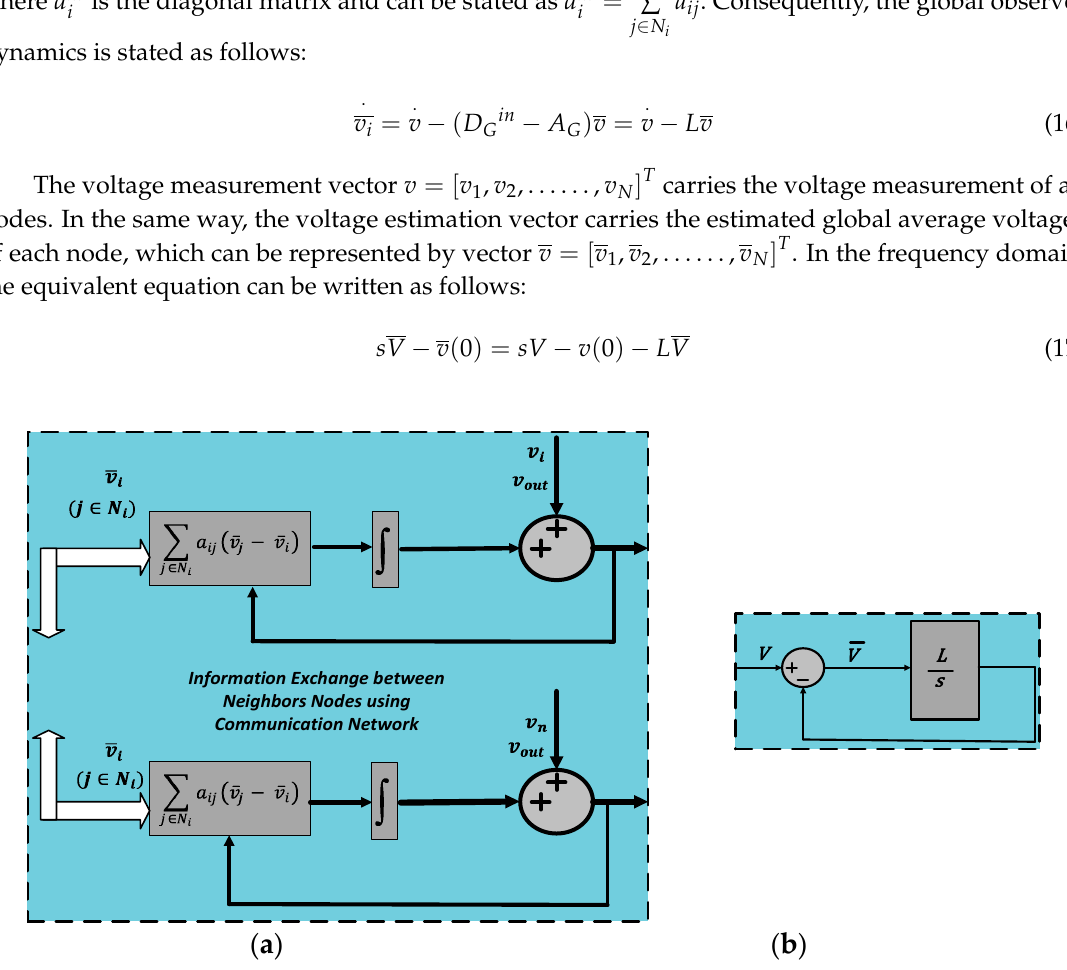
Figure 4. Dynamic consensus protocol overview. ( a ) Averaging procedure for a particular node; ( b ) global averaging procedure in frequency domain.